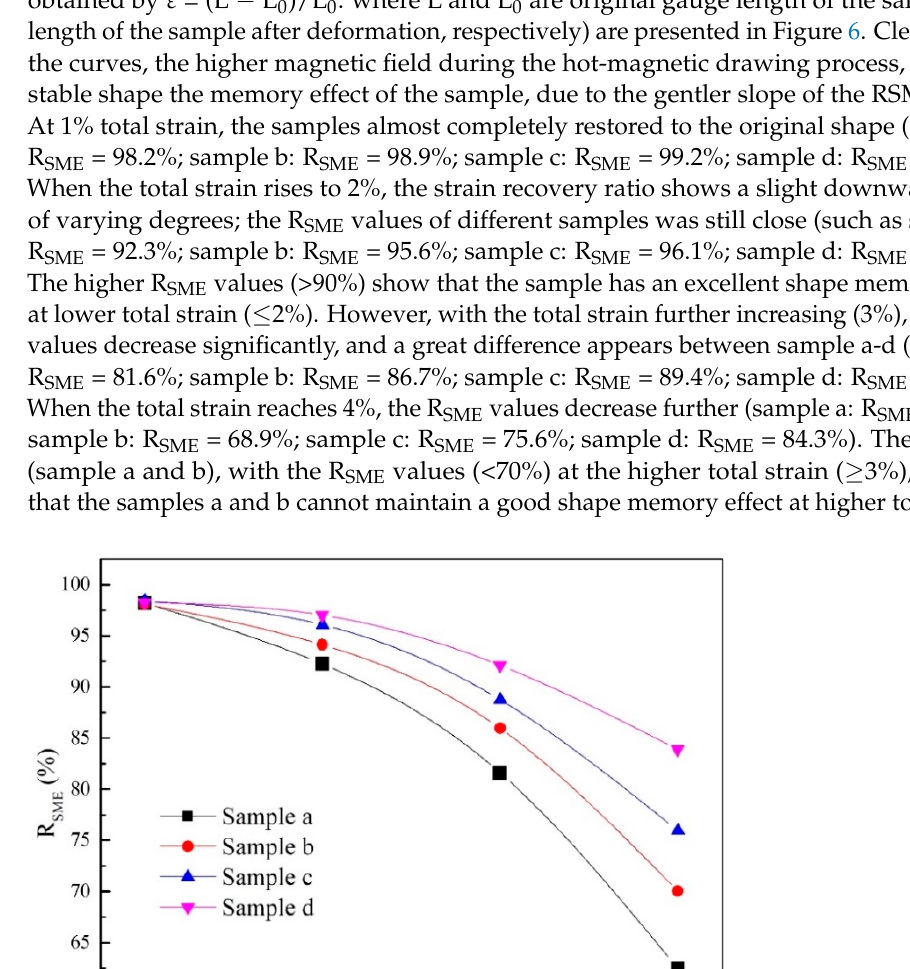
Figure 5. The TEM image ( A ) and SAED analysis ( B ) of martensite.